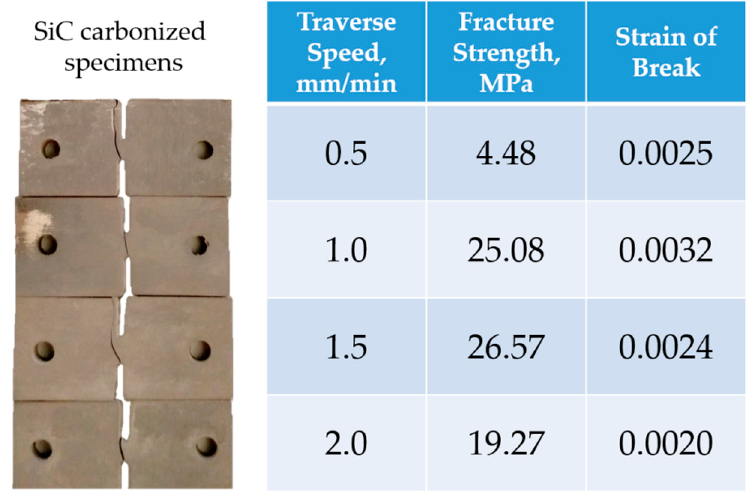
Figure 2. Experimental characteristics obtained for carbonized specimens filled with SiC and tested for 0.5, 1.0, 1.5, and 2.0 mm/min traverse speeds.